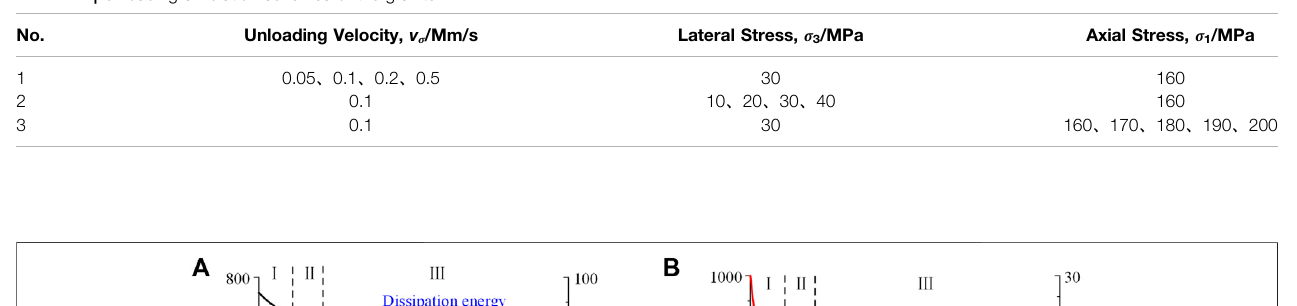
Frontiers in Earth Science |